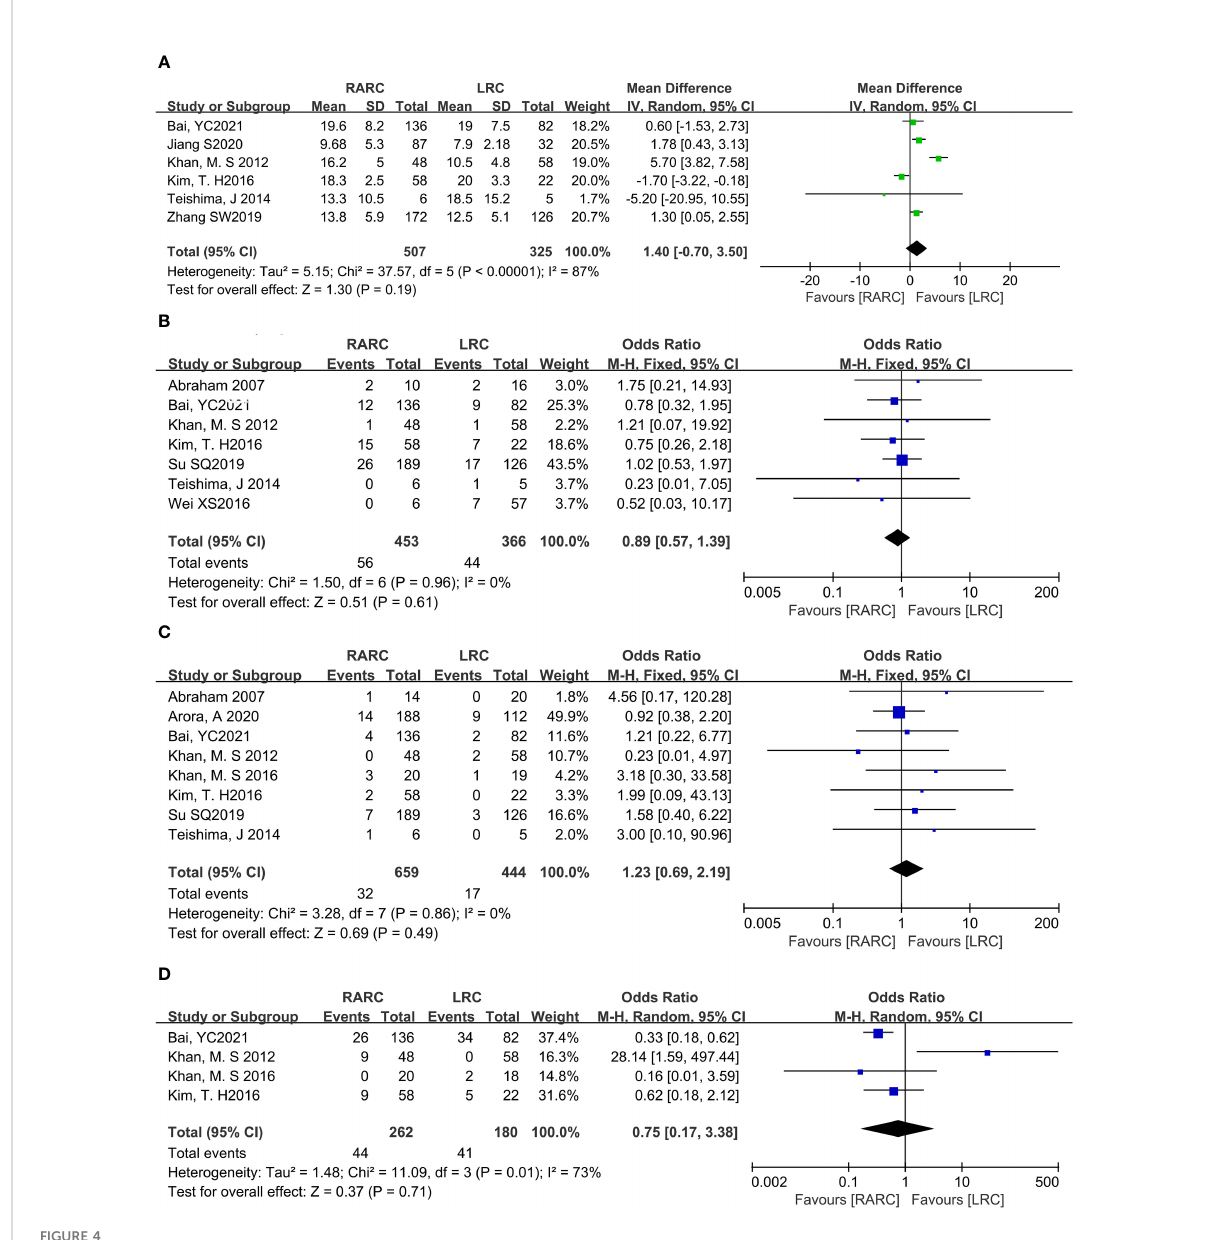
FIGURE 4 Forest plot of RARC versus LRC on the oncologic outcomes. (A) The mean lymph nodes, (B) The positive lymph nodes, (C) The positive surgical margins, and (D) Cancer-related